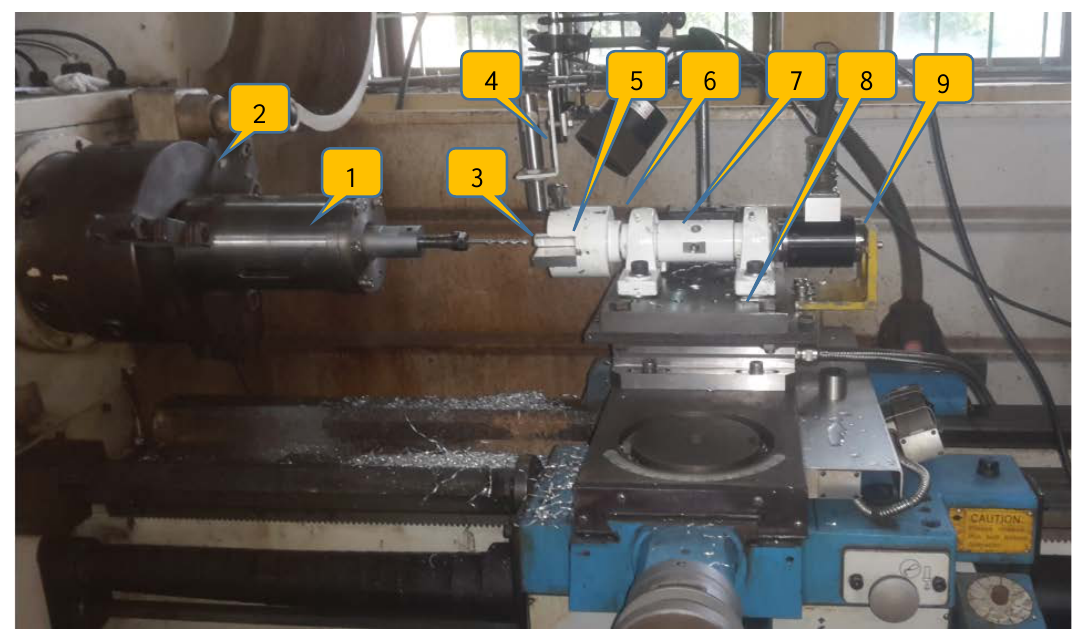
Figure 3. A photo of the experimental tests.